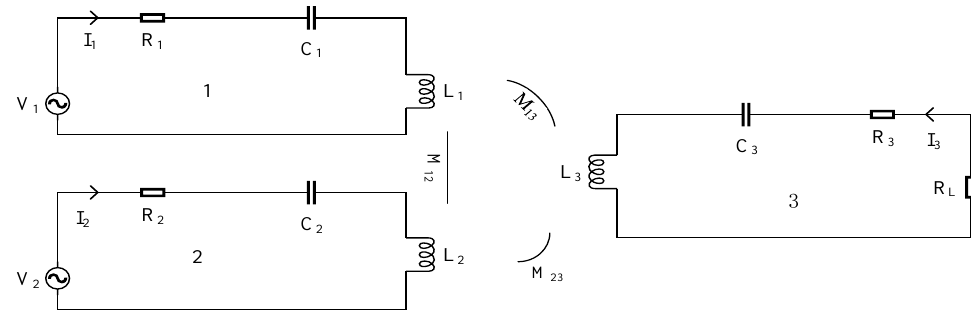
Figure 3. Two active to receiver charging modes.